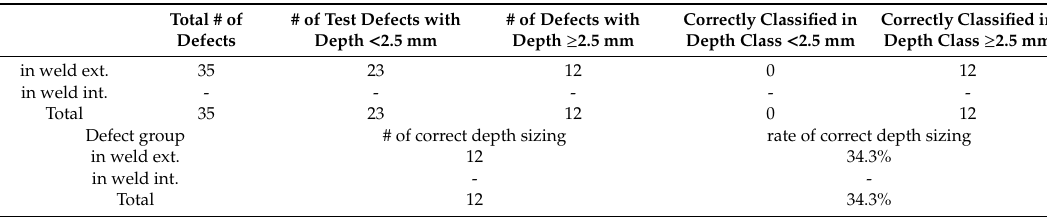
Table 2. Depth sizing accuracy of defects in weld.